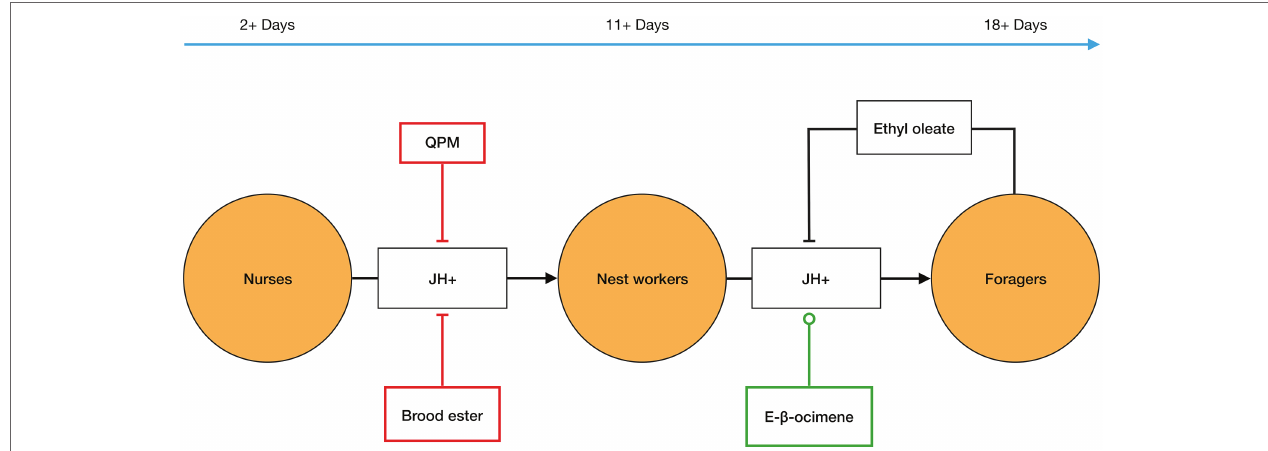
FIGURE 1 | Temporal polyethism. Worker bees, in A. mellifera , transition between the temporal worker castes, orange circles , as internal levels of juvenile hormone ( JH ) increase, represented as JH+ . JH biosynthesis is affected by external factors, including inter-member signals: QPM, brood ester, E- β -ocimene, and ethyl oleate . QPM, brood ester, and ethyl oleate inhibit JH biosynthesis, flat-ended lines , and E- β -ocimene promotes JH biosynthesis, circle-ended line . The inter-member signals allow the ratio of the temporal worker castes to be controlled at the colony level, see text for more details . The timeline represents the typical age of workers in each caste in the active summer period.